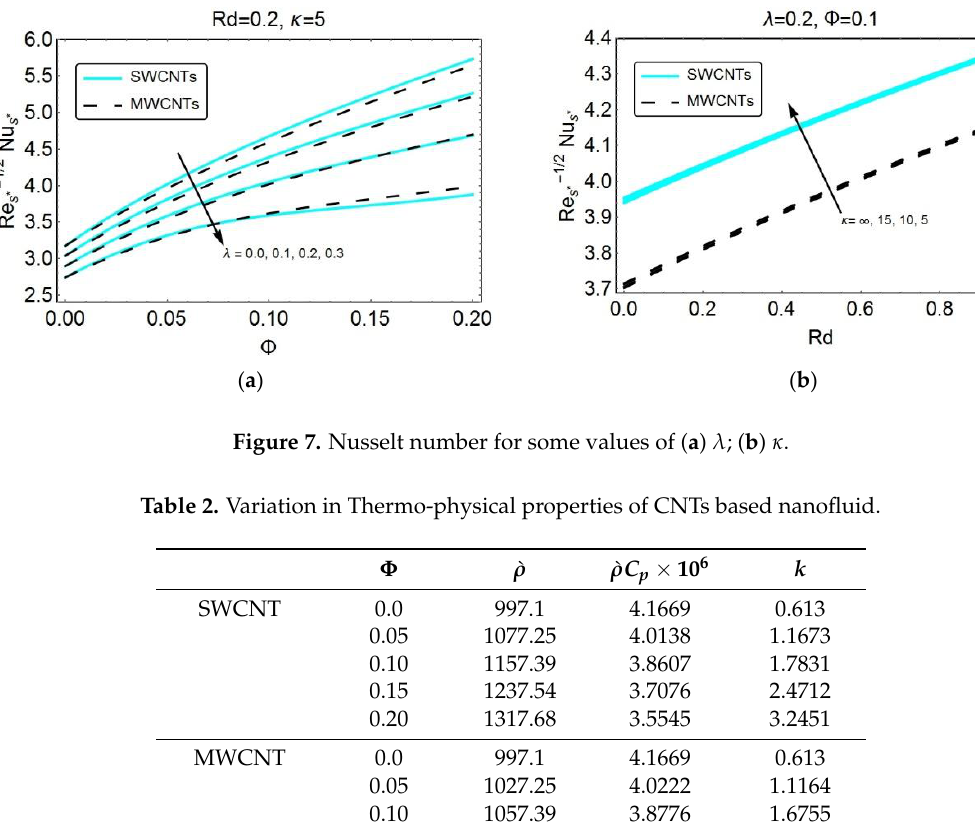
Figure 6. Skin friction coefficient for some values of: ( a ) Φ ; and ( b ) 𝜅.